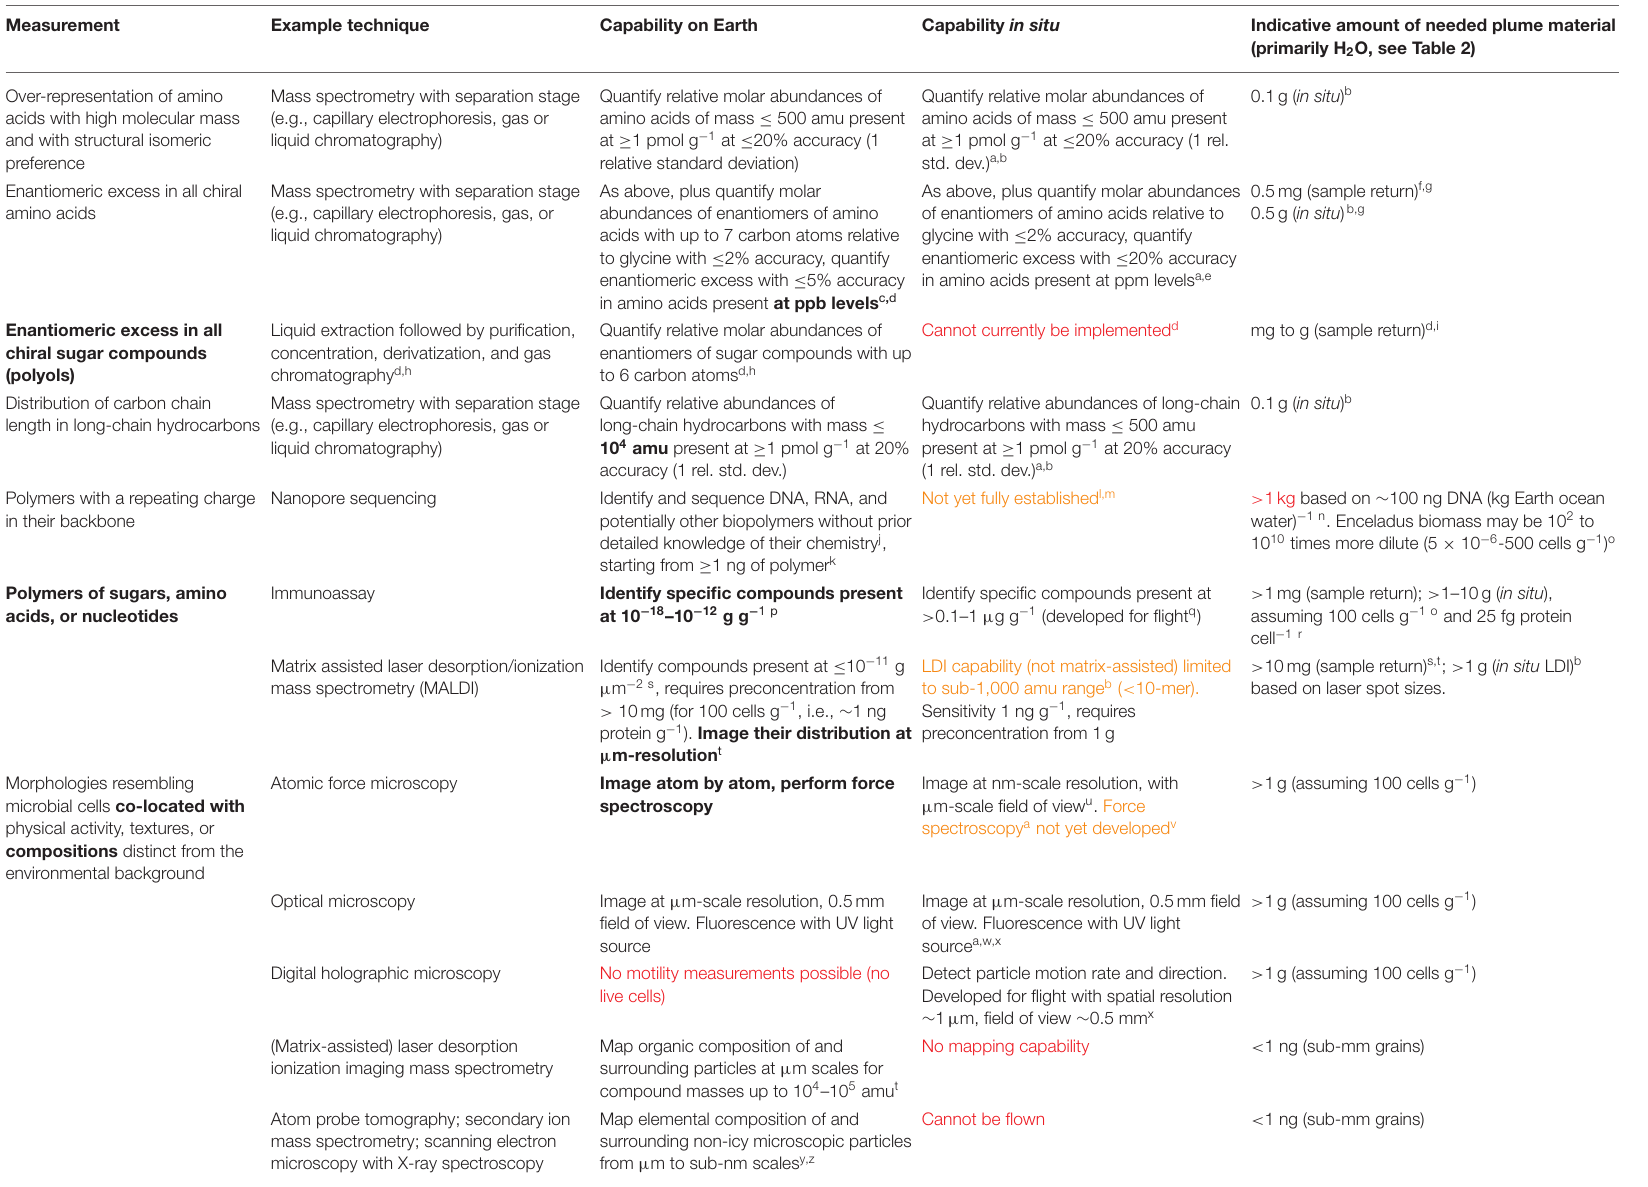
TABLE 3 | Life detection capabilities on returned samples (composition described in Table 2 ) compared to in situ , example options for implementation, and corresponding indicative amount of sample